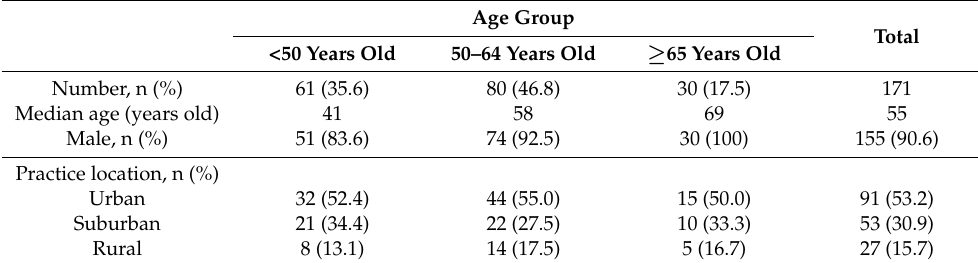
Table 1. Family physicians’ characteristics by age groups.